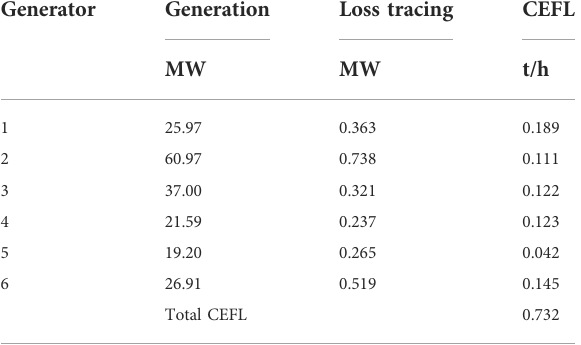
TABLE 8 The comparison of active power output and active load data. Generator